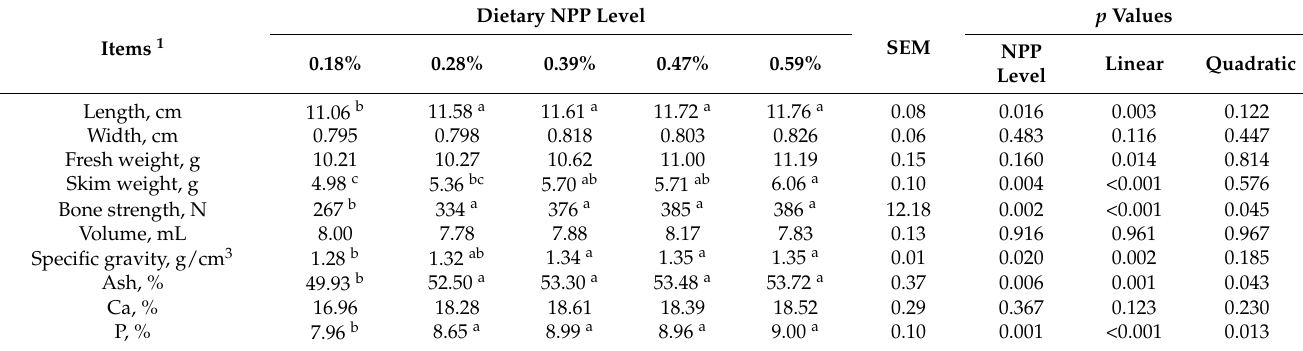
Table 4. Effects of dietary non-phytate phosphorus (NPP) levels on the tibia variables in 28-day- old goslings.